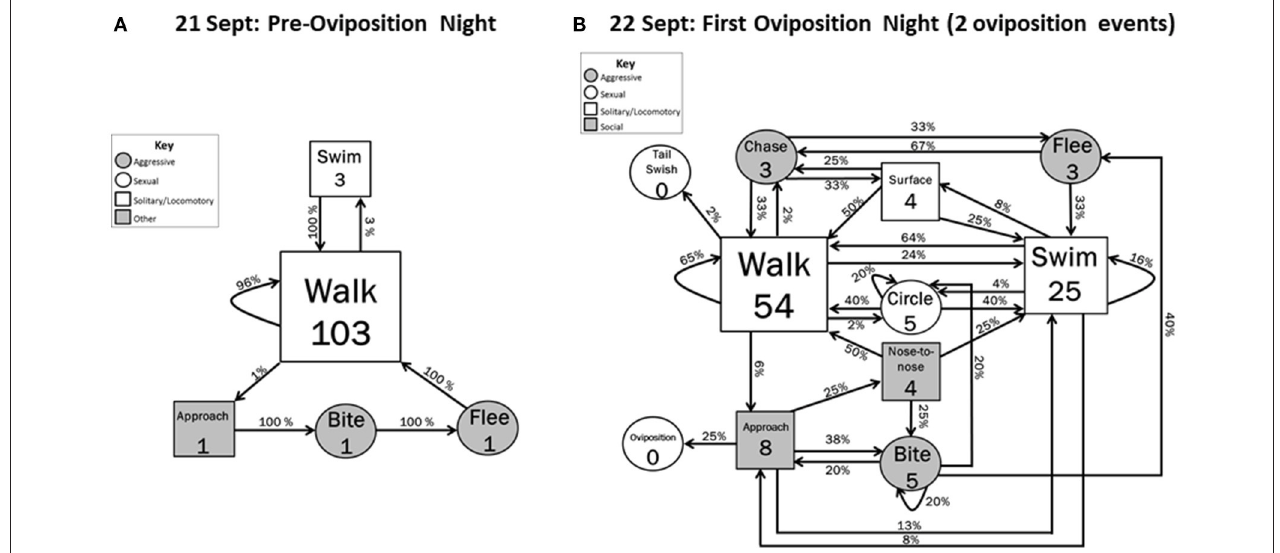
FIGURE 2 | Behavioral transitions during (A) the night before the oviposition events occurred and (B) the first night of oviposition when 2 oviposition events occurred. Frequency of initiating behavioral actions (inside boxes) and % time initiated action was followed (arrow) by other actions are indicated. Zeros indicate that the behavior occurred but did not initiate a sequence within the 5min designated time frame. Shape sizes are indicators of the relative frequency in which the initiating behavior occurred (e.g., larger boxes indicate the behavior occurred more often than smaller boxes).